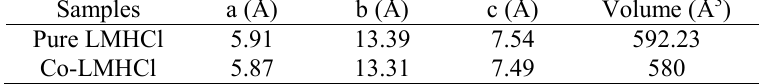
Table 1. Cell parameters of pure and metal ions doped LMHCL single crystals.